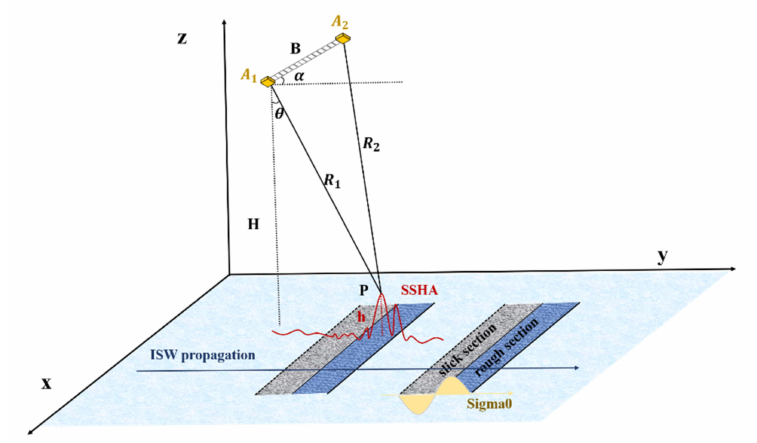
Figure 10. Schematic diagram of ISWS observed by InIRA on